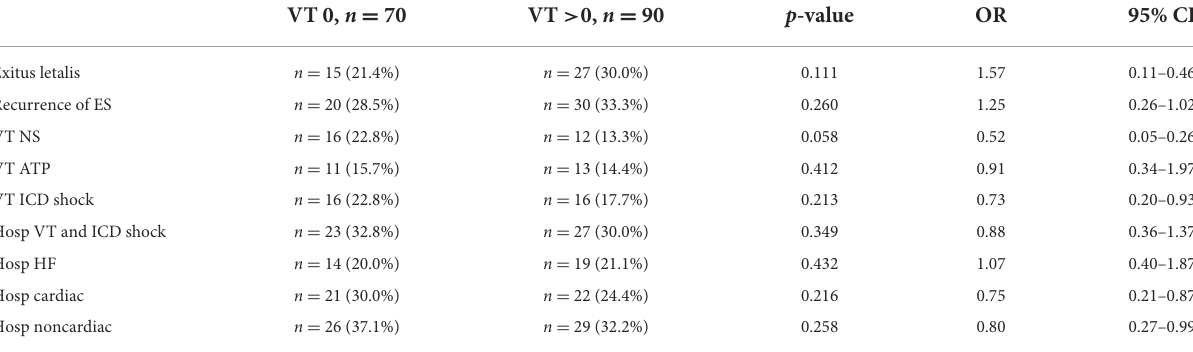
TABLE 8 Analysis between no clinlincal VT vs. clinical VT